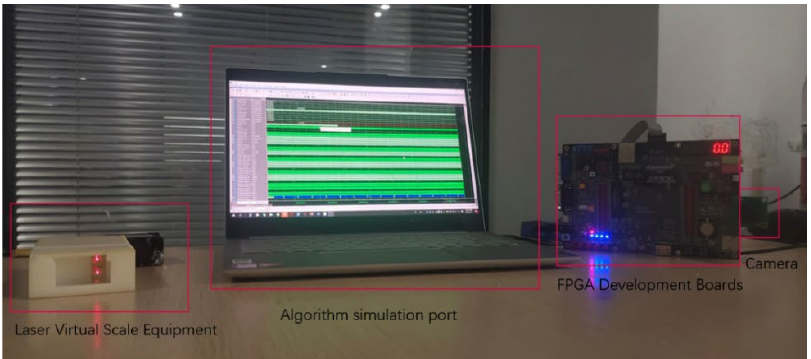
9 of 15 Figure 10. FPGA hardware implementation.